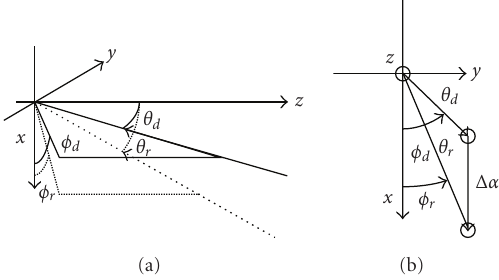
Figure 3: Antenna reference system 3D view (a) showing the angles characterizing the direction of arrival of the direct and reflected ray. (b) 2D view of the xy plane, with highlighted the di ff erence in the angle of arrival Δ α